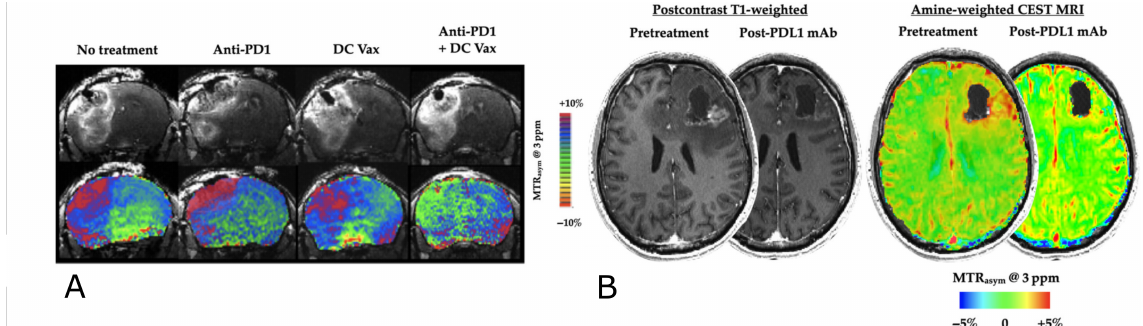
Figure 4. Immunotherapy treatment response monitoring using amine-weighted CEST imaging. ( A ) Postcontrast T 1 -weighted images (top) and amine-weighted CEST images (bottom) obtained during combination immunotherapies with dendritic cell vaccination and anti-PD-1 treatment. A re- sponse to the treatment is manifested as a decreased CEST signal (green compared to red in the left-hand side of the brain); ( B ) post-contrast T 1 (left) and amine-weighted CEST (right) images from a recurrent glioblastoma patient treated with PD-L1 demonstrating a successful response characterized by homogenization of the CEST Amine contrast. Reproduced with permission from Cho et al. NMR in Biomedicine 2022;e4785. doi:10.1002/nbm.4785 [150]. Copyright ©2022 John Wiley & Sons